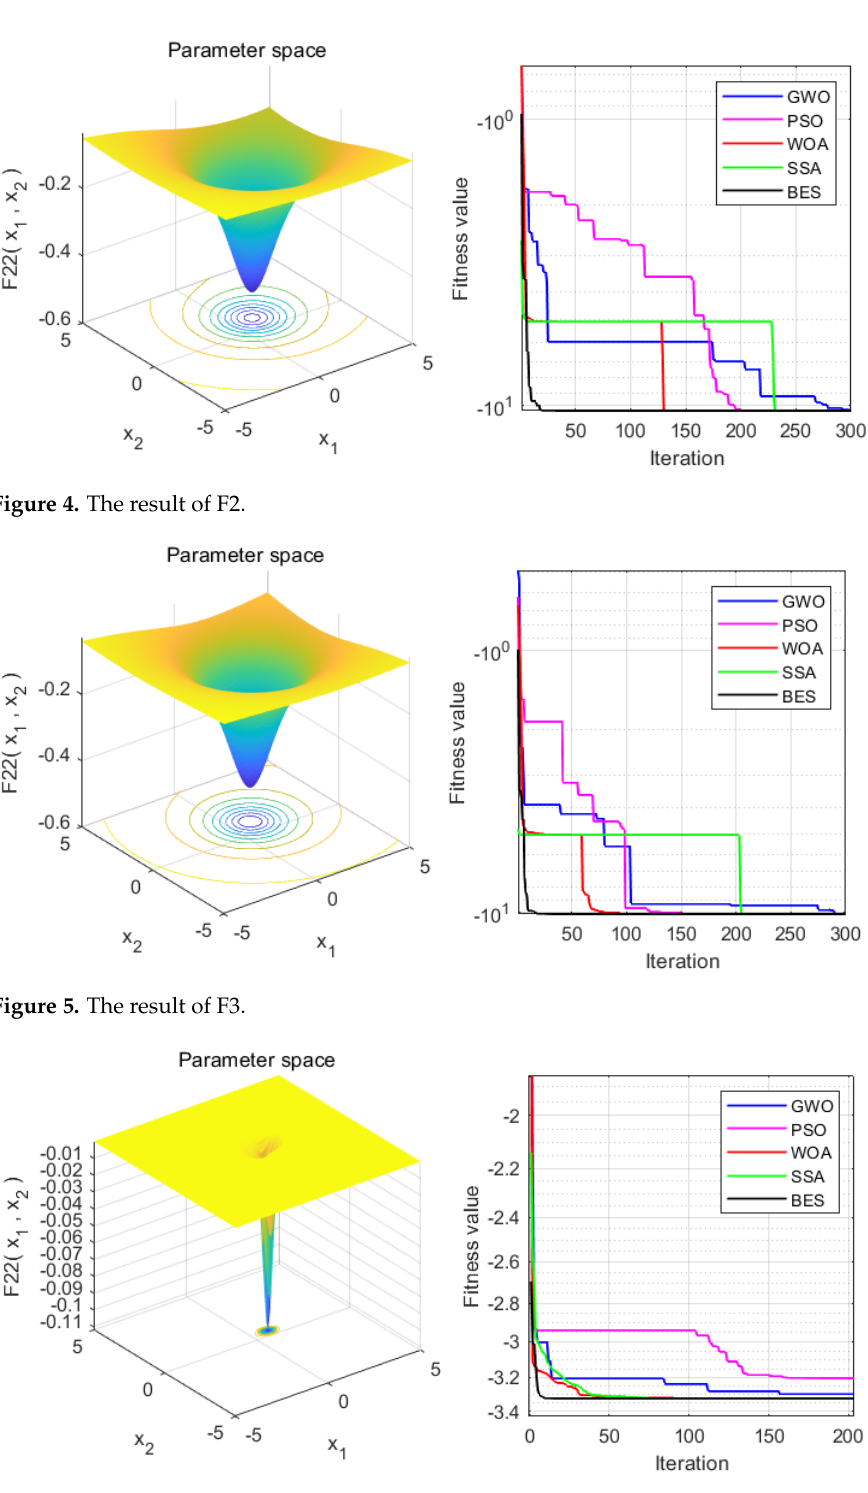
Figure 6. The result of